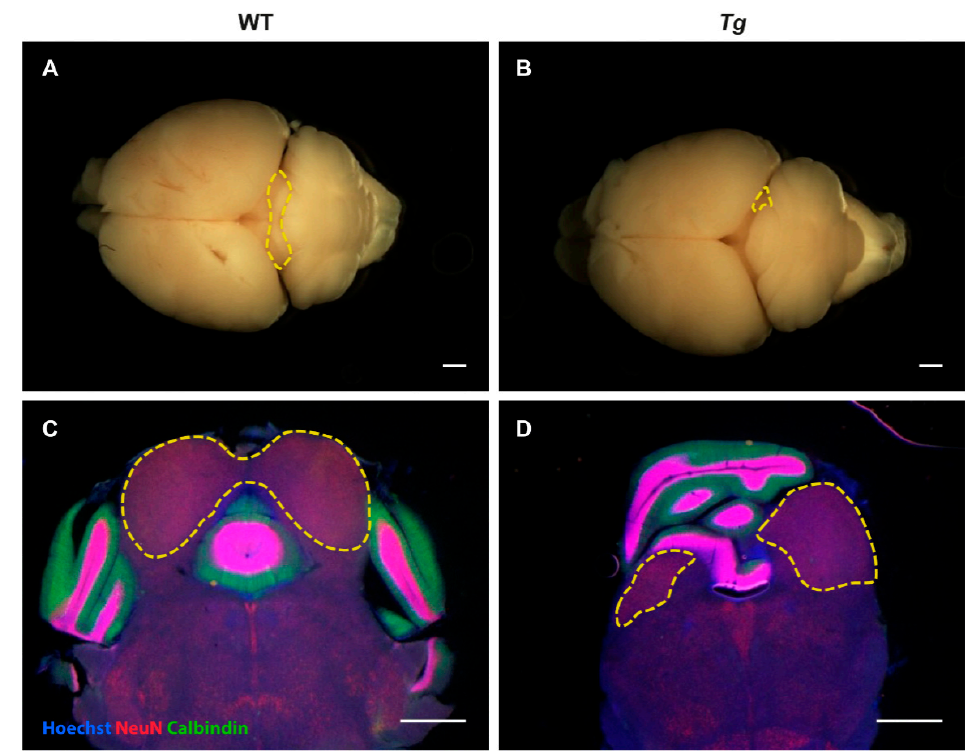
Figure 2. Size and position of the inferior colliculus in WT and Tg brain (animals with highly expressed phenotype). ( A , B ) Simple inspection of the brain surface from the dorsal view reveals smaller size of inferior colliculus in Tg brain (delineated in B ) compared to WT brain (delineated in A ). ( C , D ) Same finding confirmed using stained coronal brain sections. Scale bar 1